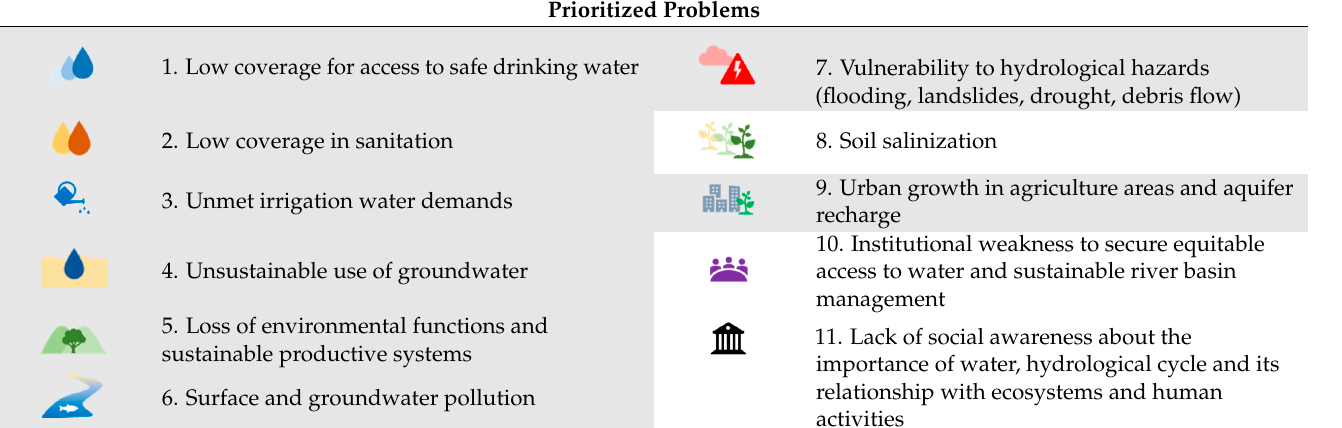
Table 1. Problems prioritized by stakeholders in the Rocha River Basin and incorporated in the scoping in WEAP model (shaded in gray).